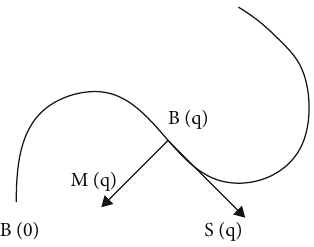
Figure 3: Schematic diagram of curve tangent vector and normal